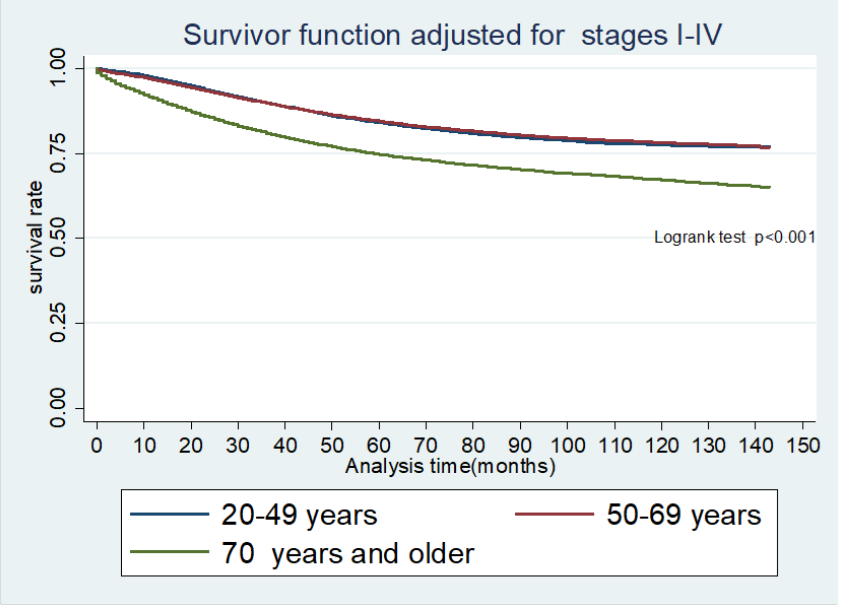
Figure 5. Kaplan Meier survivor function for Median CRC-specific survival (CSS) for an age group adjusted for CRC stages.